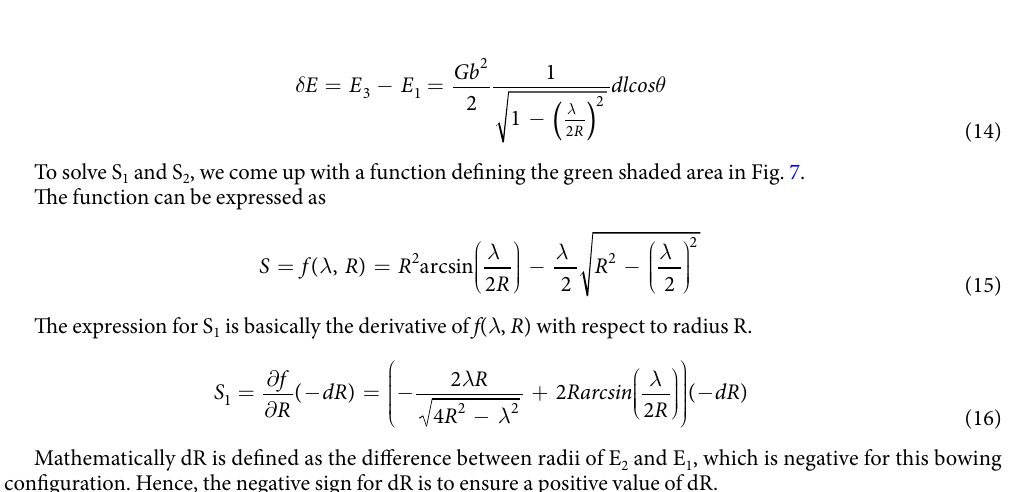
Figure 7. Schematic shows area of different regions. The green shaded area is the dislocation swept area before interfacial glide is initiated. The sum of orange and blue shaded area is the swept area caused by bowing and interfacial